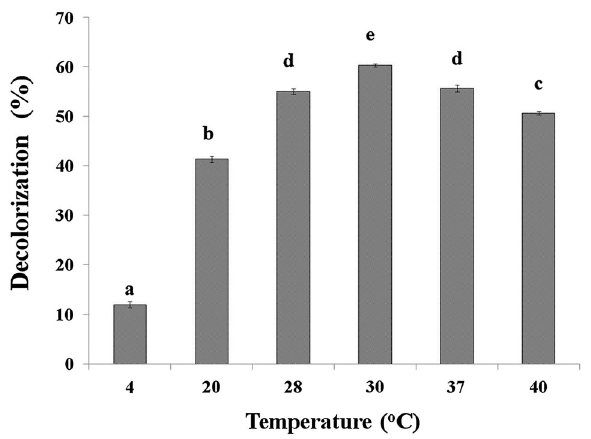
Fig. 5 Effect of